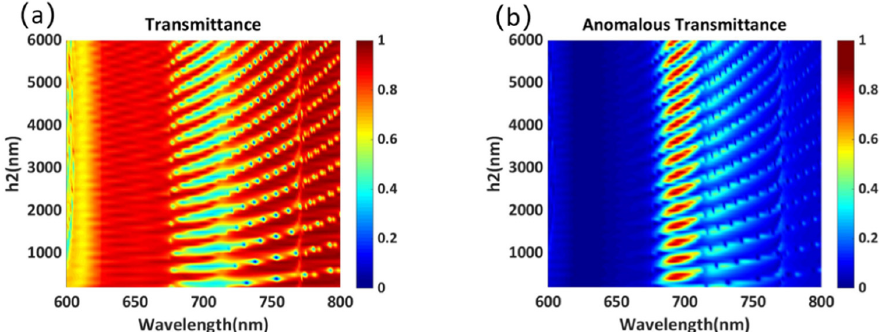
Figure 10. ( a ) Transmittance and ( b ) anomalous transmittance as a function of the thickness h 2 .